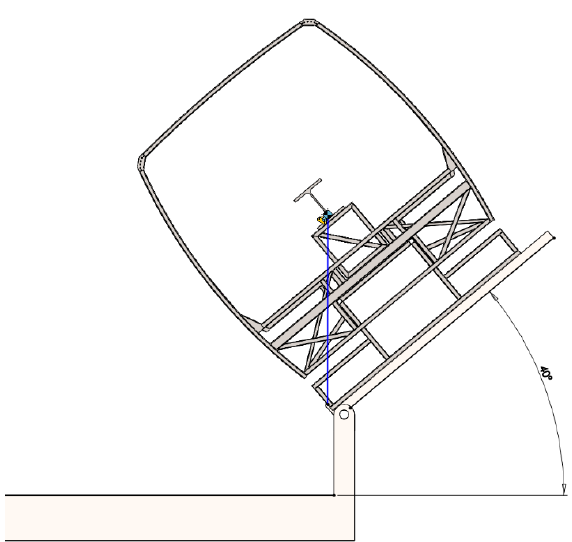
Figure 4. The computational model of a rollover of the safety frame: 1—concrete base, 2—tip-up platform, 3—rollover safety frame model, 4—additional weight, 5—sensors for contact detection.